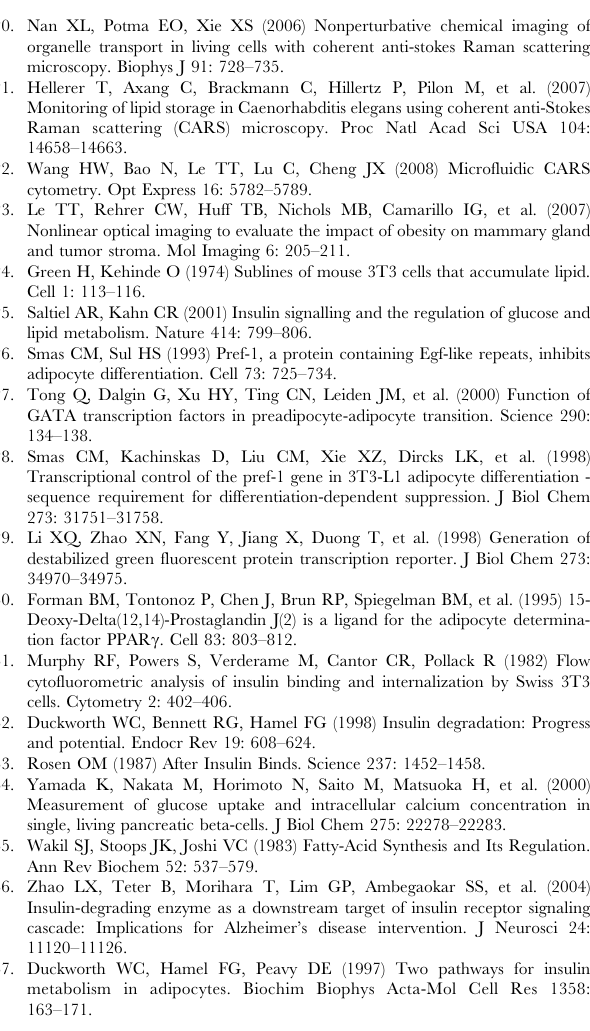
at 0.3 mM for 1 minute and subjected to flow cytometry analysis. Average fluorescence intensities of 2000 cells at each concentration are presented. Error bars represent distribution across 4 repeated experiments. Figure S5 Insulin binding and glucose analog uptake as functions of days after induction. (A) Labeled insulin binding as a function of days after induction. 3T3-L1 cells at specified days are treated with 10 ug/ml of labeled insulin for 5 minutes and subjected to flow cytometry analysis. (B) Fluorescent glucose analog uptake as a function of days after induction. 3T3-L1 cells at specified days are first washed with glucose-free media for 2 hours, then treated with 0.3 mM of fluorescent glucose analog for 1 minute and subjected to flow cytometry analysis. Average fluorescence intensities of 2000 cells at each specified day are presented. Error bars represent distribution across 4 repeated experiments. On the x-axis, 4lp, 6lp, and 8lp represent lipid-poor cell populations sorted with flow cytometry on day 4, day 6, and day 8, respectively. On the x-axis, 4lr, 6lr and 8lr represent lipid- rich cell populations sorted with flow cytometry on day 4, day 6, and day 8, respectively.